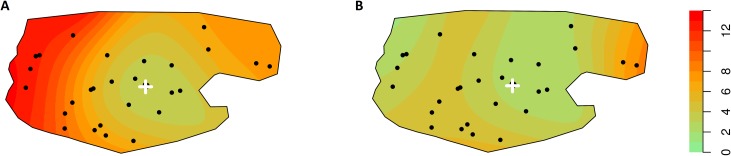
Geospatial representation of CFR from December 25th, 2012 to February 28th 2013 (A), and from March 1st, 2013 to October 9th, 2013 (B) , Aketi Health Zone, Province Orientale, Democratic Republic of Congo. The white cross is at the location of the central hospital of Aketi. The scale represent the CFR expressed in %. The 40 dots represent the cluster locations.